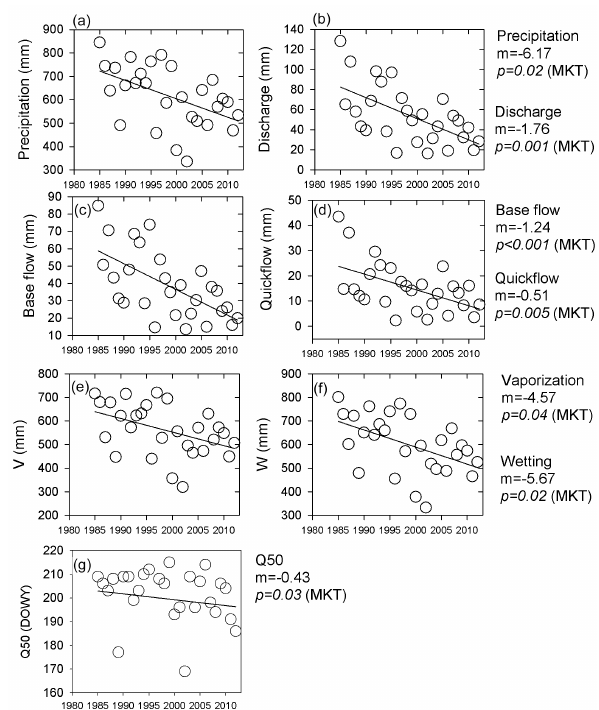
Figure 2. Precipitation and water partitioning at the upper Jemez River catchment scale. There was a significant decreasing trend quantified by the Mann–Kendall test (MKT) in the JRB precip- itation and all the components of the water partitioning. For in- stance, precipitation at the catchment scale decreased during the last 3 decades at a rate of 6.17mm per year and discharge at 1.76mmyr − 1 . Q 50 indicated that discharge is occurring 4.3 days earlier per decade.